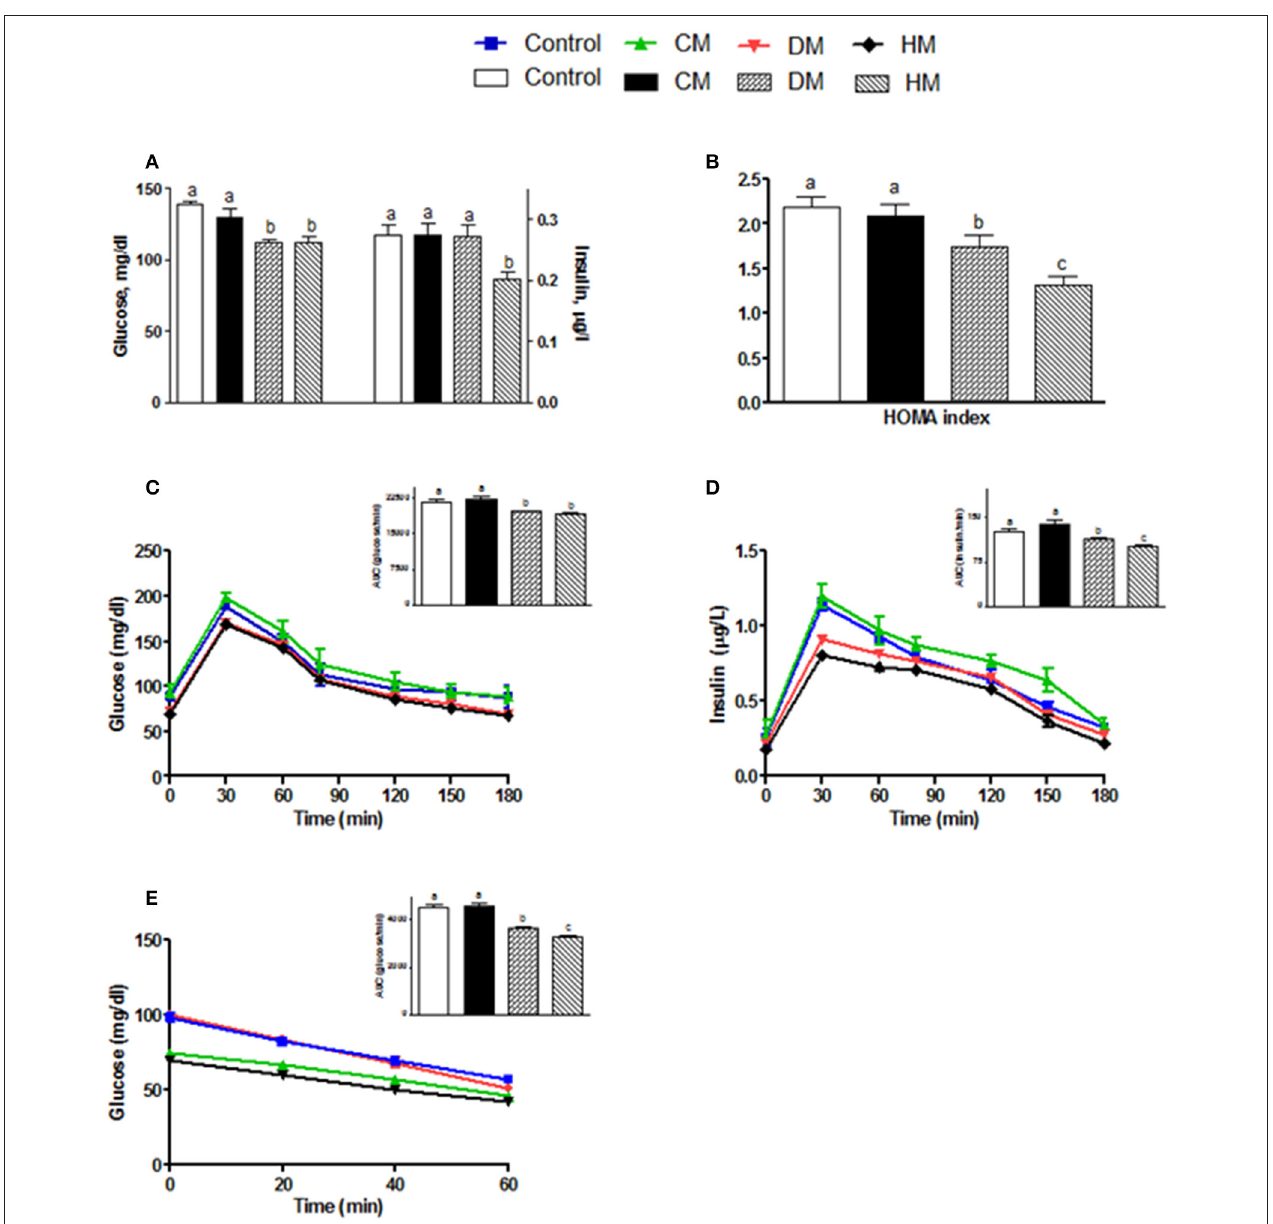
FIGURE 2 | Effects of oral administration of human, donkey and cow milk on glucose homeostasis . The graphs show the plasma levels of glucose and insulin (A) , the Homa-index (B) , the plasma glucose (C) , and insulin (D) concentrations at different time points after glucose load, and insulin tolerance test (E) . The histograms in (C–E) , represent the area under curve (AUC) related to each condition. Data are presented as means ± SEM from n = 7 animals/group. Labeled means without a common letter differ ( P < 0.05).